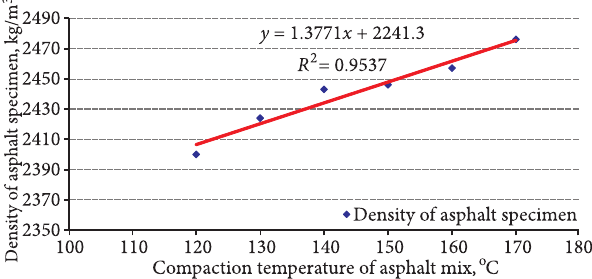
Fig. 6. Dependence of compaction temperature and density of asphalt specimens